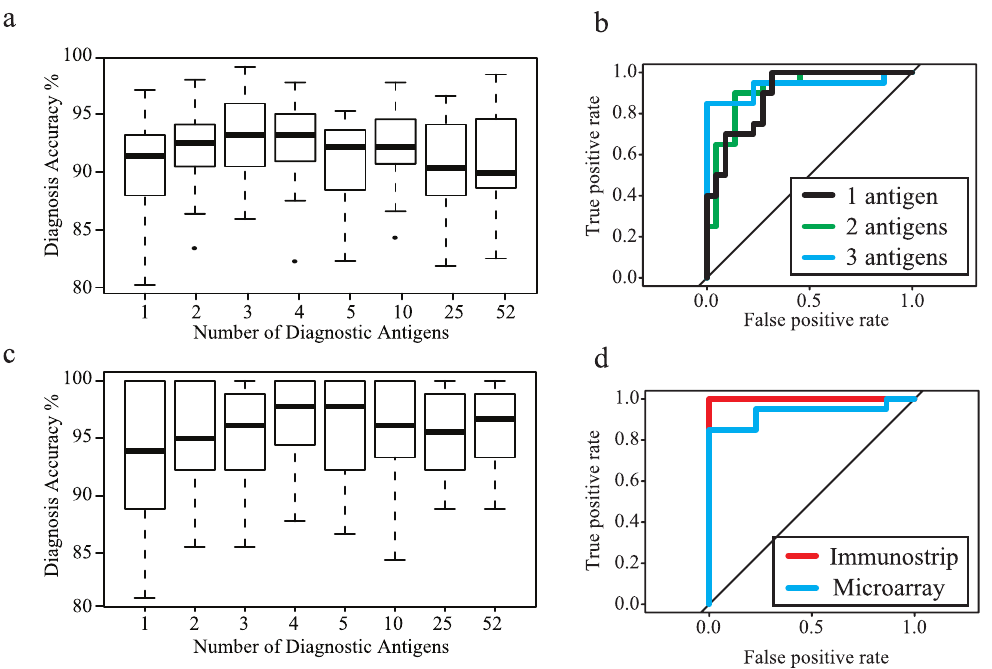
Figure 6. Multiple antigen classifier. The boxplots show classifiers with increasing number of serodiagnostic antigens. (a) Boxplots for the microarray classifier using the top 1, 2, 3, 4, 5, 10, 25, 52 antigens (b). The ROC curves were generated for each antigen set and a maximum predictive accuracy of 93%. ROC curves show that accuracy increases as multiple antigens are used to generate the classifier when increasing from 1 to 2 antigens, and from 2 to 3 antigens. (c) Boxplots for the classifier using the immunostrips are plotted. (d) A comparison of the ROC curves for the diagnostic accuracy of the microarray platform using 3 antigens compared to the ROC curve of immunostrips using 4 antigens.